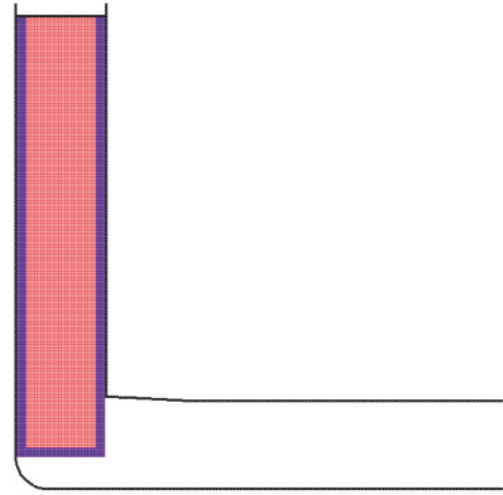
Figure 10: ECAP model with can based on SPH.